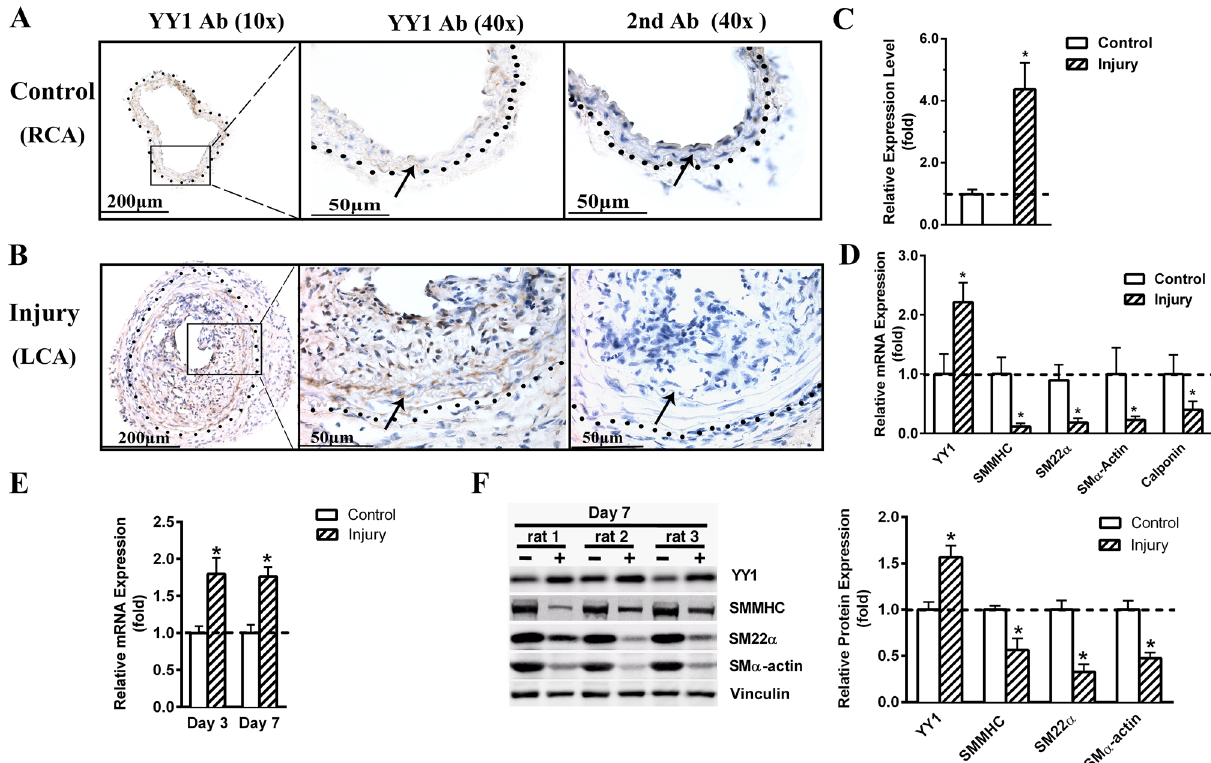
Figure 1. Carotid injury induces YY1 expression and inhibits SMC differentiation. ( A–D ) Mouse carotid arteries were ligated for two weeks. ( A,B ) Representative IHC images show that YY1 expression is low in the uninjured right carotid artery (Control, RCA) and injury induces YY1 expression in the neointima-media layer of the injured left carotid artery (Injury, LCA). The YY1 antigen positive signal is increased in the injury- induced neointima-media layer between the lumen and the adventitia. The black dots indicate the border between media and adventitia of the vessel wall. The adjacent section incubated with the secondary antibody (2 nd Ab) alone serves as the negative control. The arrow indicates the same position in the media layer SMCs on two adjacent sections. Scale bar: 200 μm (10X); 50 μm (40X). ( C ) Quantification of positive IHC signals in the neointima-media layer of the vessel wall. n = 4. ( D ) qRT-PCR assays show increased expression of YY1 and decreased expression of SMC differentiation markers in injured carotid arteries. n = 6. ( E,F ) Rat carotid arteries after balloon injury for 3 or 7 days. ( E ) qRT-PCR assays show increased expression of YY1 in response to injury. n = 6. ( F ) Western blot assays show increased expression of YY1 and decreased expression of SMC differentiation markers SMMHC, SM22α and SMα-actin in the injured carotid arteries. Quantification of band density is shown on the right. n = 3. Vinculin serves as the loading control for WB. The uncropped original blots are presented in Supplementary Figure S3. All quantification data are presented as mean ± SEM. * P < 0.05 versus